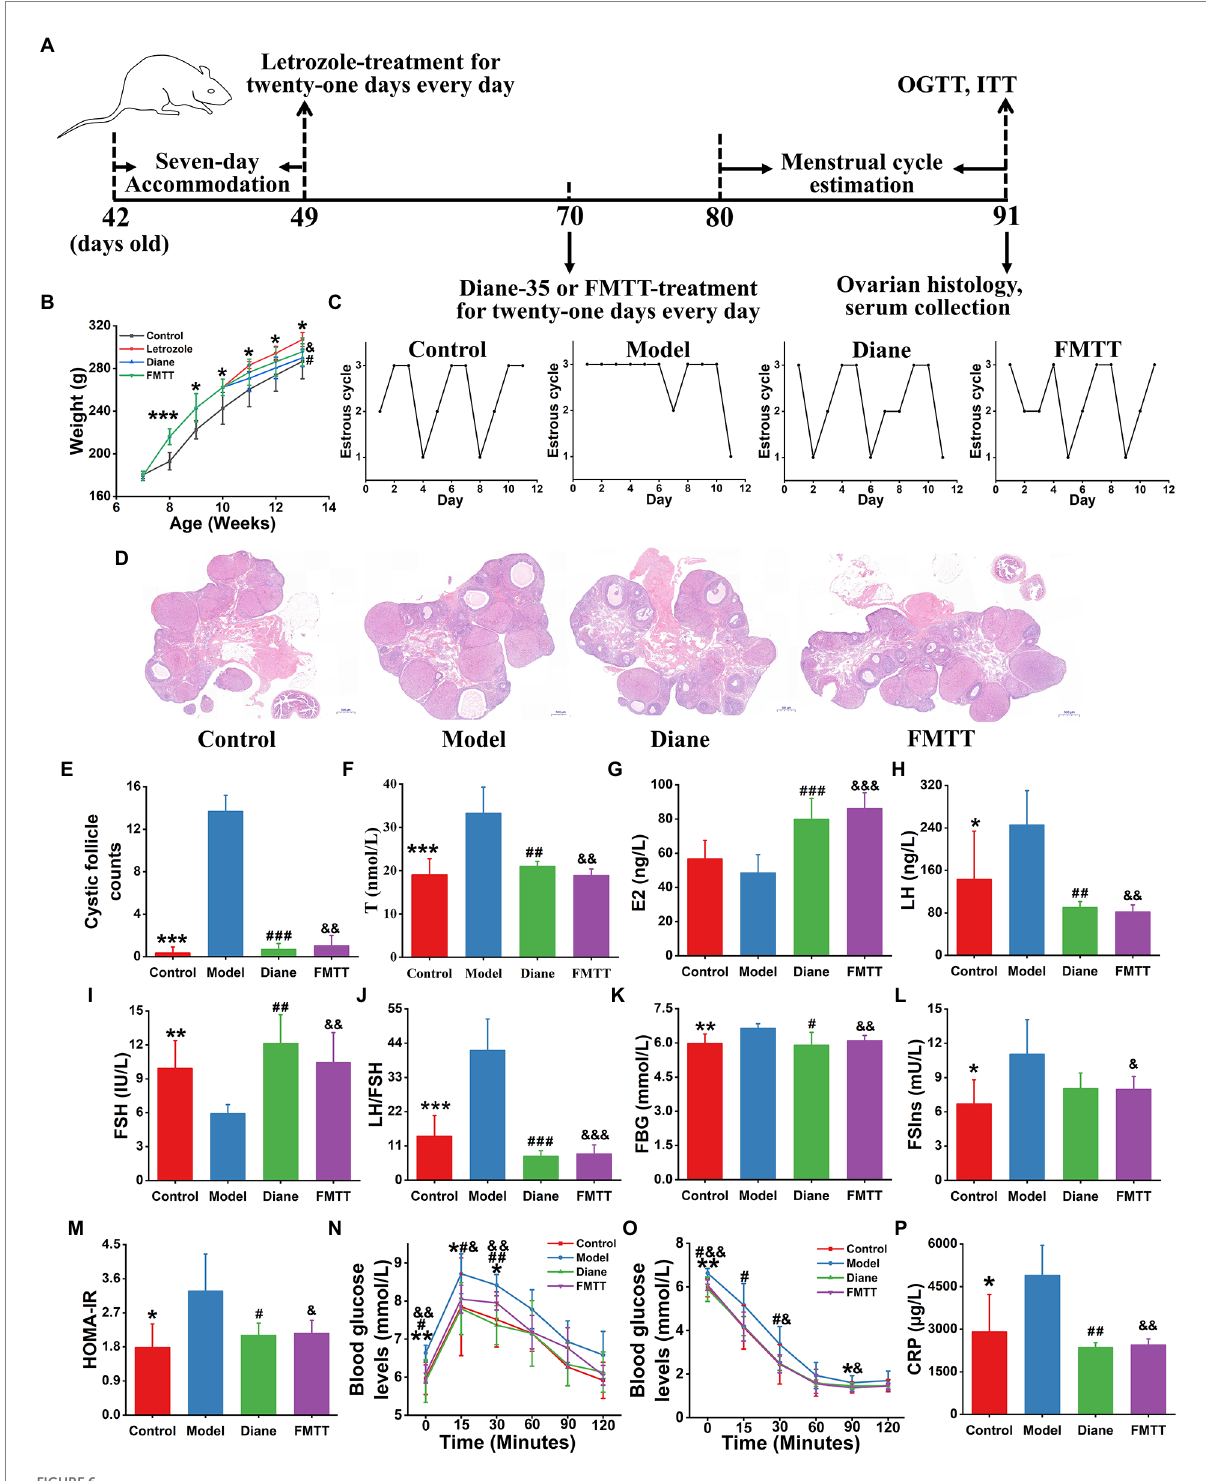
FIGURE 6 Healthy fecal microbiota attenuated letrozole-induced PCOS. (A) The schedule of this animal experiment; FMTT, the treatment by fecal microbiota transplantation; OGTT, oral glucose tolerance test; and ITT, insulin tolerance test. (B) Body weight change. (C) Menstrual cycle estimation. (D) Ovarian histopathology. (E) Cystic follicle counts. Biochemical parameters include the levels of T (F) , E2 (G) , LH (H) , FSH (I) , LH/FSH (J) , FBG (K) , FSIns (L) , HOMA-IR (M) , OGTT (N) , ITT (O) , and CRP (P) in rats; T, testosterone; E2, estradiol; LH, luteinizing hormone; FSH, follicle-stimulating hormone; LH/FSH, the ratio of LH to FSH; FSG, fasting serum glucose; FSIns, fasting serum insulin; HOMA-IR, homeostasis model assessment of insulin resistance (HOMA-IR = FBG × FSIns/22.5); and CRP, C-reactive protein. n = 6 rats in each group. Data are shown as mean ± standard deviation. Difference among four groups is compared by one-way ANOVA followed by Tukey’s post-hoc test. *represents the comparison between control and PCOS model groups (* p < 0.05, ** p < 0.01, *** p < 0.001). # stands for the difference between diane-35 treatment and PCOS model groups ( # p < 0.05, ## p < 0.01, ### p < 0.001). & indicates the difference between FMTT and PCOS model groups ( & p < 0.05, && p < 0.01, &&& p <